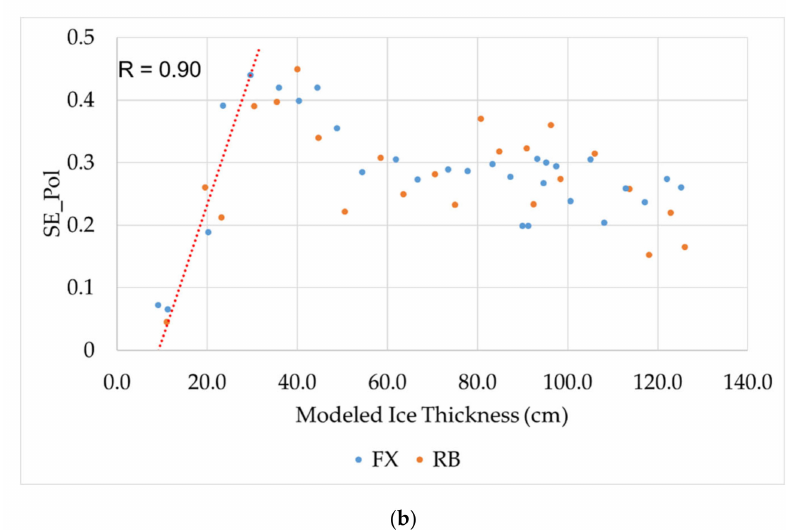
Figure 8. Temporal evolution of the ( a ) intensity and ( b ) polarimetric components of the Shannon entropy with ice thickness. Red trend line is included for values in the range sensitive to ice thickness. R is the correlation coe ffi cient of linearly regressed